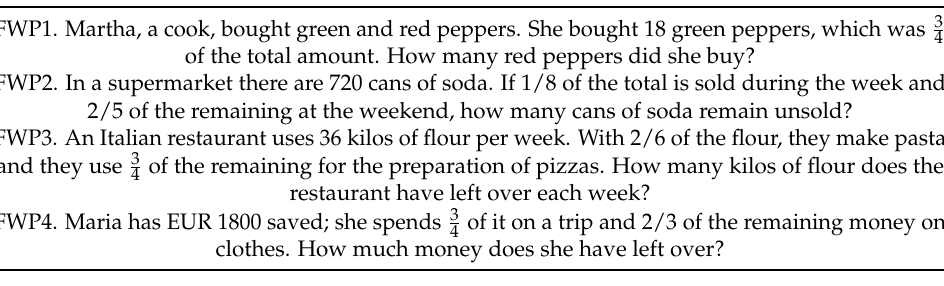
Table 3. Fraction word